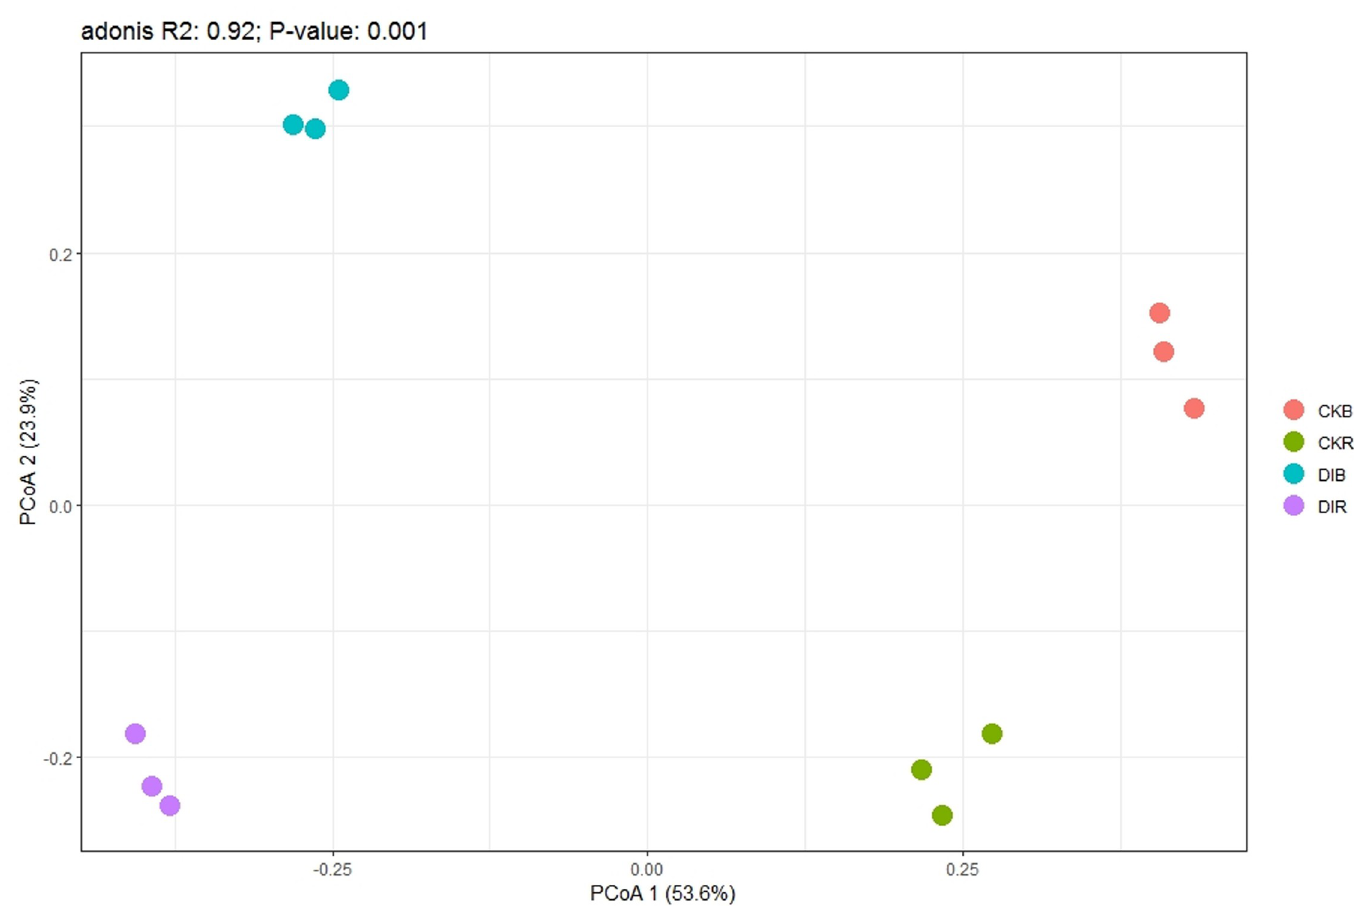
Fig 3. PCoA of soil fungal communities in drip-irrigated and flood-irrigated soils used to grow alfalfa (beta diversity).